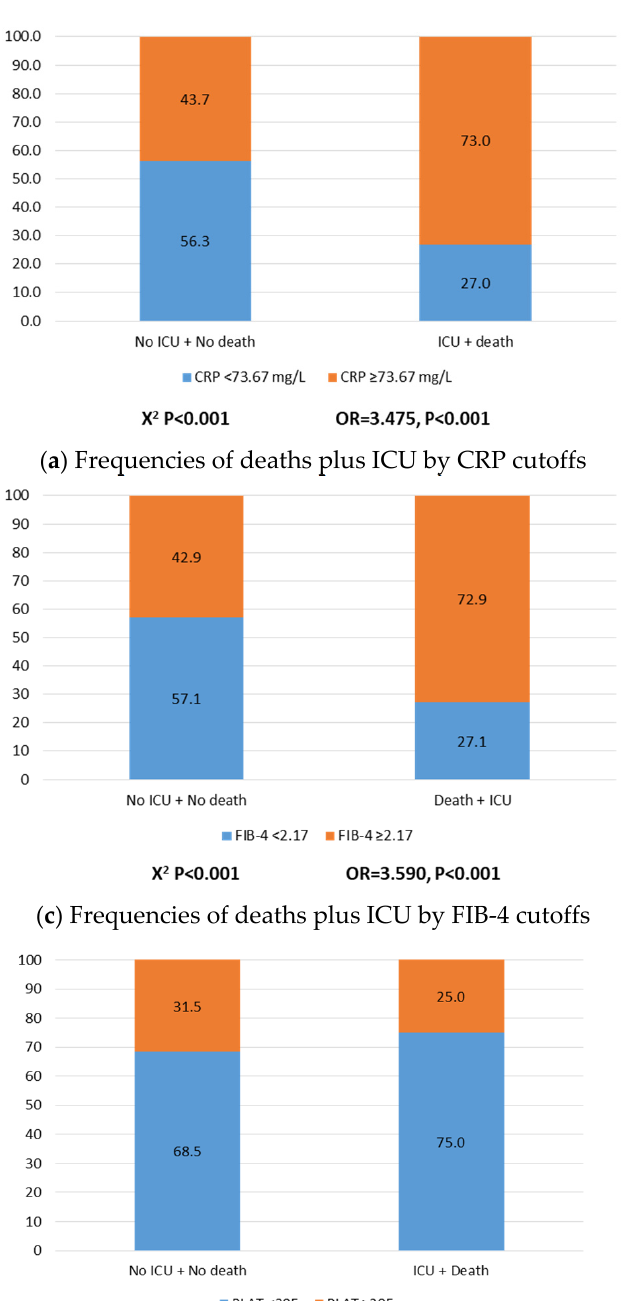
Figure 2. ROC curves showing the predictive value of CCI (no age), CRP, NEU, FIB-4, PLAT, and AAR concerning COVID- 19 outcomes (ICU plus Death). 4. Discussion As a result of the increased availability of data and collaborations between research- ers, efforts have been made for the evaluation of laboratory tests and other phenotypical information as biomarkers related to COVID-19 disease severity [9]. This study should be considered a proof of concept, where biochemical and clinical variables significantly ex- plained morbid and fatal outcomes in COVID-19 patients, including neutrophils, CRP, P<0.001 0 . 00 0 . 25 0 . 50 0 . 7 5